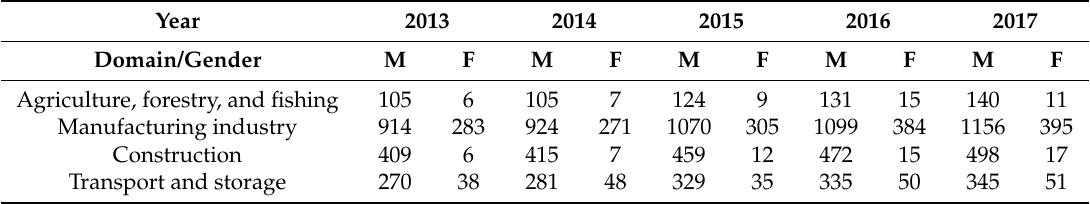
Table 2. The distribution of accidents in Romania by gender [22].